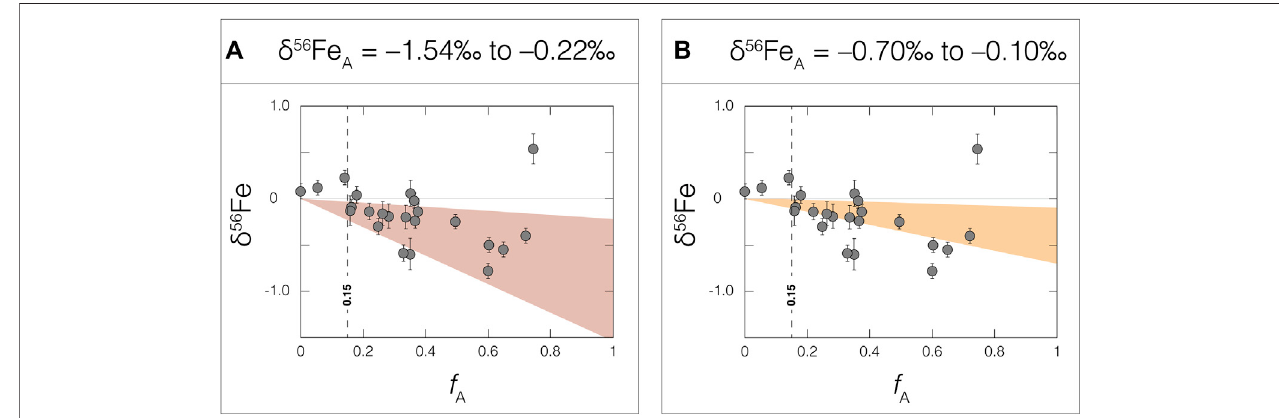
FIGURE 5 | Bulk-shale δ 56 Fe values plotted versus calculated authigenic Fe fractions ( f A ). The red fi eld in panel (A) signi fi es an authigenic δ 56 Fe source that can reconcileallbutfourdatapoints( δ 56 Fe= – 1.54 ‰ to – 0.22 ‰ ),whiletheorange fi eldinpanel (B) signi fi esanauthigenic δ 56 Fesourcecomparabletomodernhydrothermal inputs( δ 56 Fe A = – 0.70 ‰ to – 0.10 ‰ ;Loughetal.,2017).The0.15verticallineinbothpanelsrepresentsacut-offpoint,belowwhichtheFecontentpresentinbulk-shale samples is overwhelmingly dominated by detrital material. See the text for a description of the f A calculation.